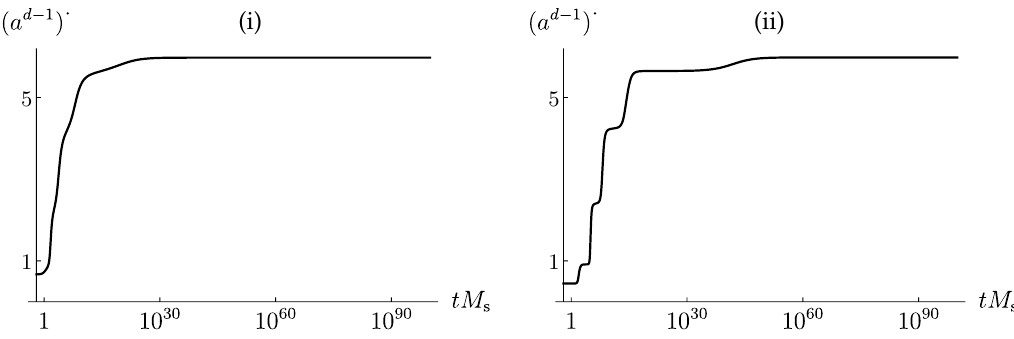
· Figure 3. (i) Convergence of ( a d − 1 ) towards a constant, signaling the entrance of the universe in QNSR. (ii) When the initial velocities of the Wilson lines are small, the final convergence is reached after successive approximate